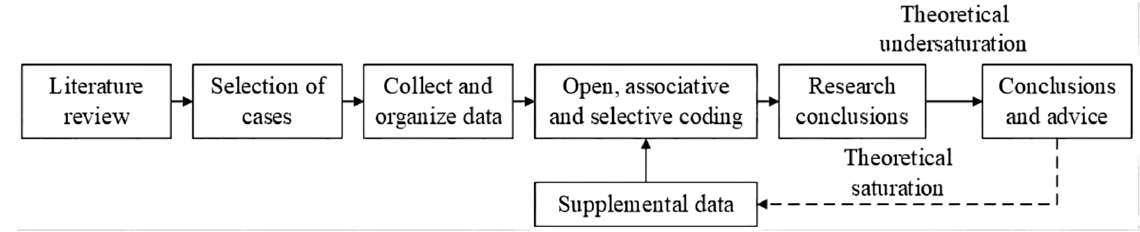
Figure 2. General grounded theory application process .